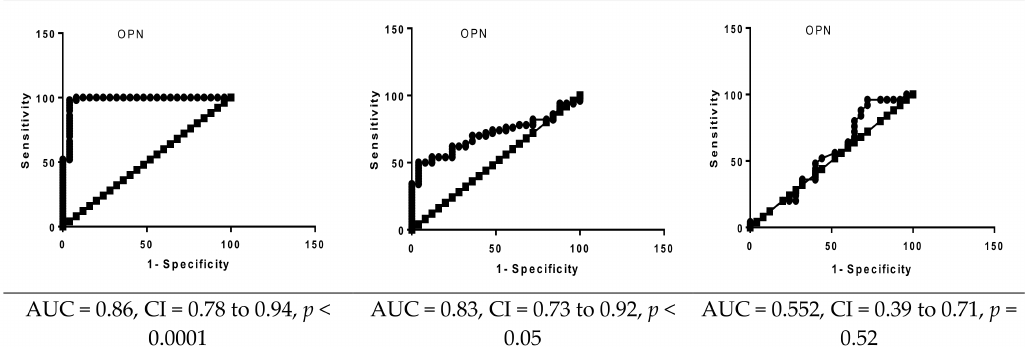
Figure 1. ROC curve analysis of serum PVT1, MALAT1, NEAT1, HOTAIR, PAI-1, and OPN levels in the breast cancer patients ( n = 50), fibroadenoma ( n = 25), and healthy controls ( n = 25). PVT1, plasmacytoma variant translocation 1 gene; HOTAIR, HOX transcript antisense RNA; NEAT1, nuclear enriched abundant transcript 1; MALAT1, metastasis associated lung adenocarcinoma transcript 1; PAI-1, plasminogen activator inhibitor-1; OPN, osteopontin; AUC, area under the curve.